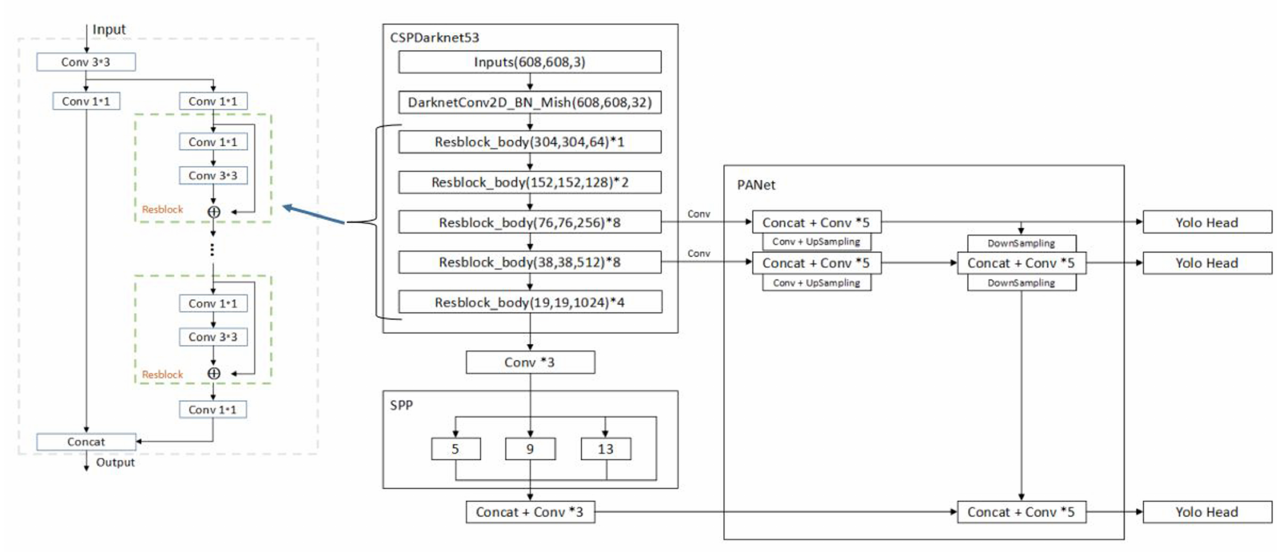
Figure 3. YOLOv4 network structure. CSPDarknet53 is the backbone feature extraction network for YOLOv4. SPP and PANet are enhanced feature extraction networks for YOLOv4. Yolo Head is the detection head of the network. The left side of the figure shows the detailed structure of the back- bone feature extraction